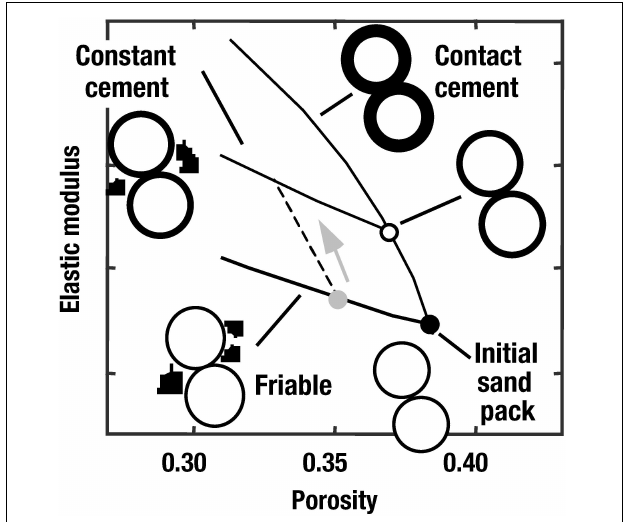
FIGURE 1 | Rock physics diagnostic models used in this study, applicable for high porosity, poorly to moderately consolidated sandstones (Avseth et al.,